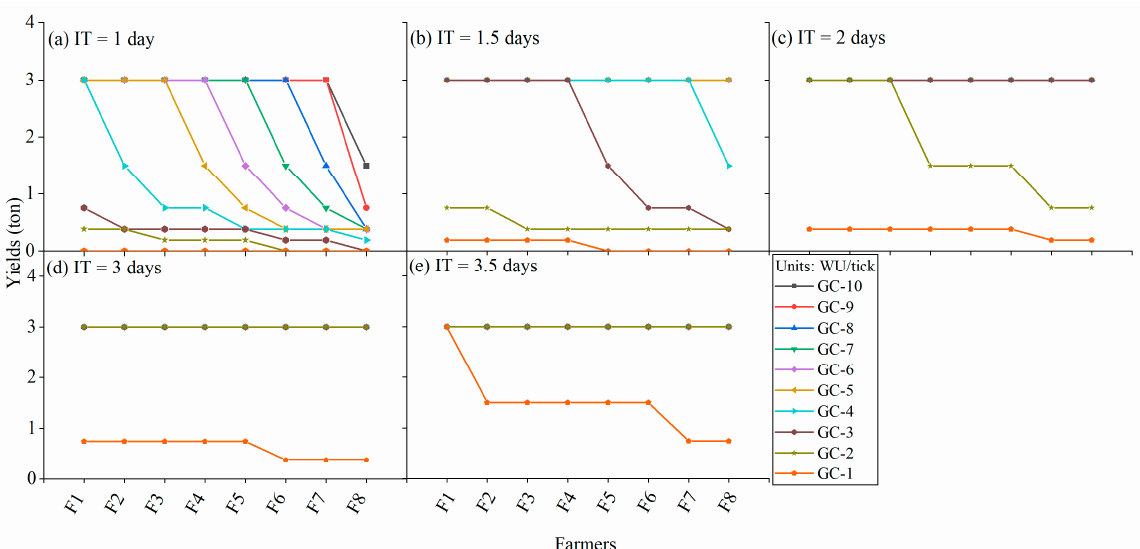
Figure 5. Yields per farmer with sufficient water under Time Control with different irrigation times: ( a ) Farmers’ yields when IT = 1 day; ( b ) Farmers’ yields when IT = 1.5 days; ( c ) Farmers’ yields when IT = 2 days; ( d ) Farmers’ yields when IT = 3 days; ( e ) Farmers’ yields when IT = 3.5 days.